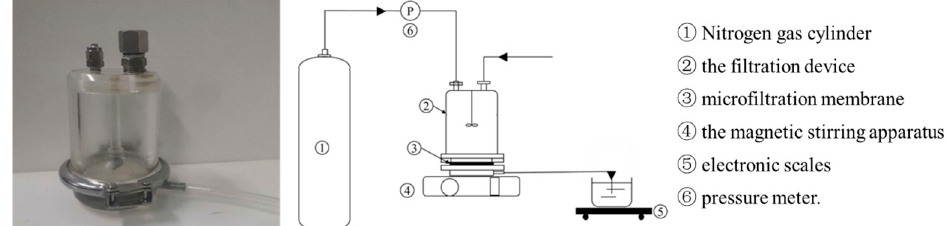
Figure 1. The illustration of the filtration